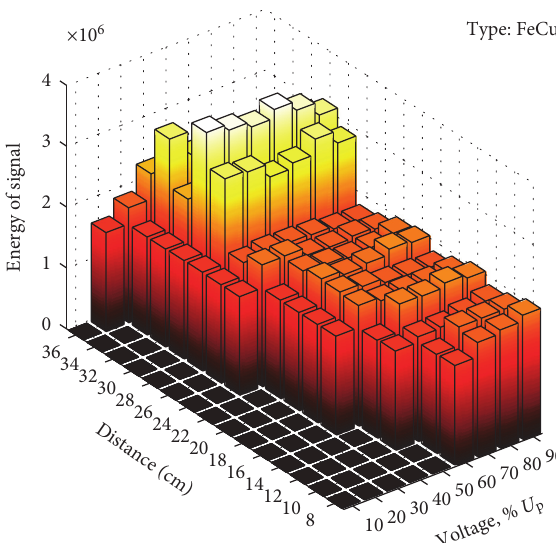
Figure 5: Dependency of voltage and distance on the value of energy of signal calculated for optical spectra emitted by corona around the AlMg5 line.